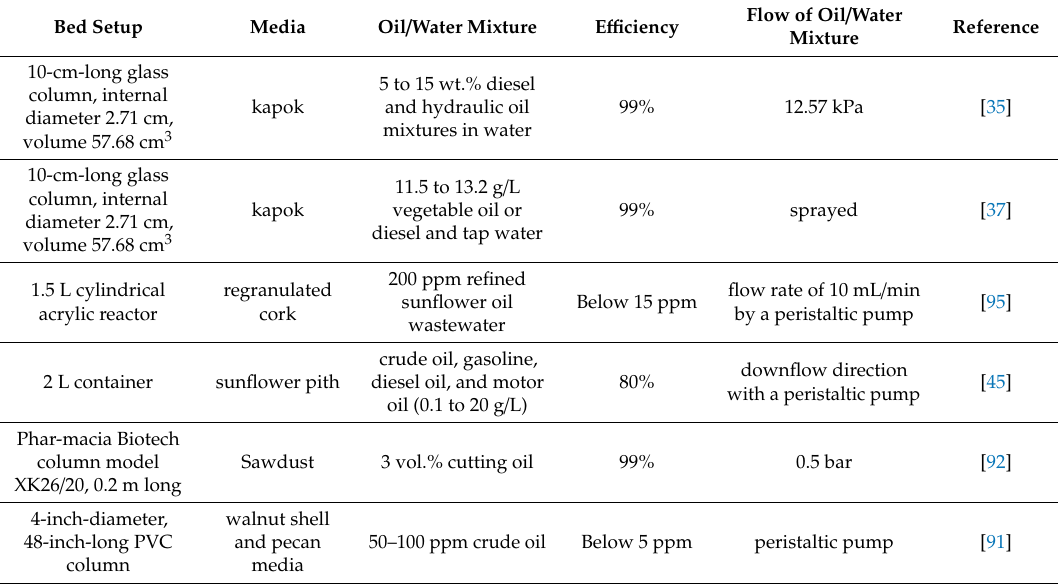
Table 5. Summary of laboratory setups used for oil / water separation through deep-bed filtration.